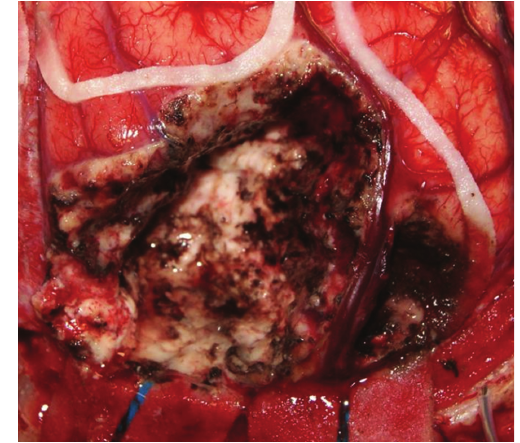
Figure 4: Intraoperative photo demonstrating the postresection cavity. The outlined eloquent areas have been preserved as well as the large cortical venous structures in the tumor